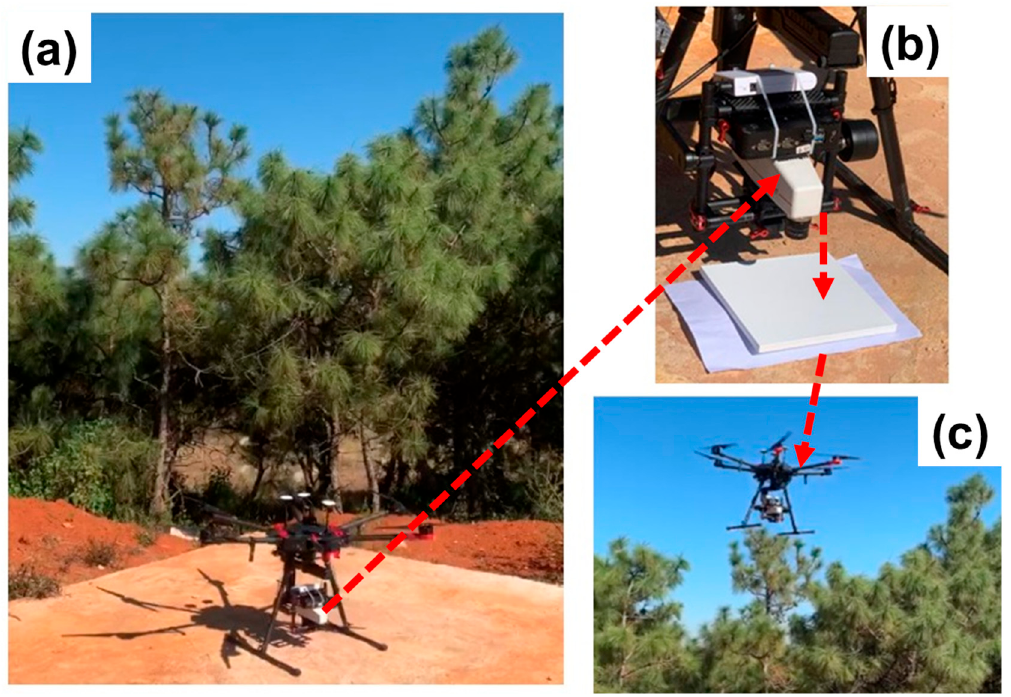
Figure 3. UAV hyperspectral imagery collection; ( a ) UAV on the ground; ( b ) Radiometric calibration; ( c ) The UAV in operation.